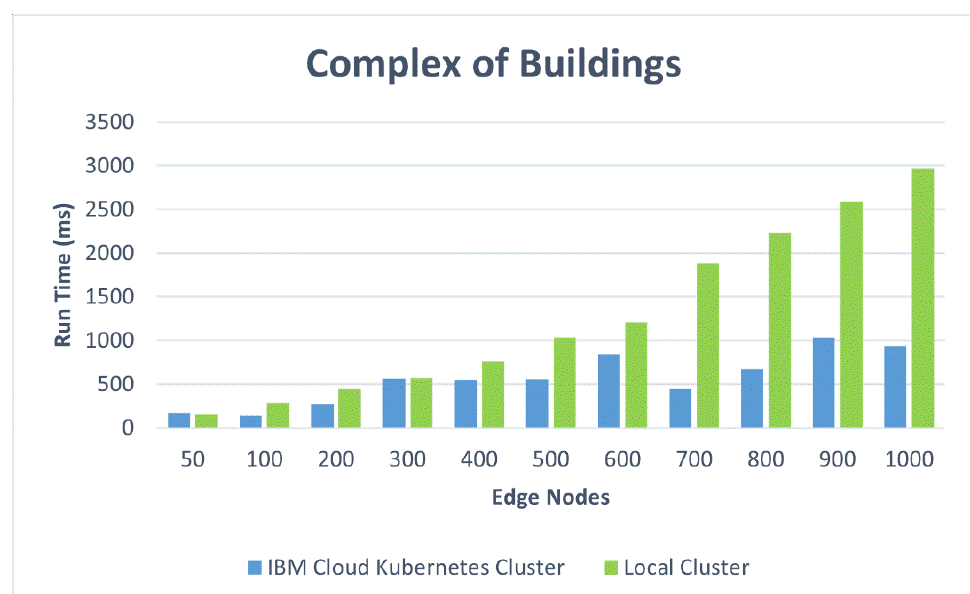
Figure 15. Comparative r un times for the complex of buildings.